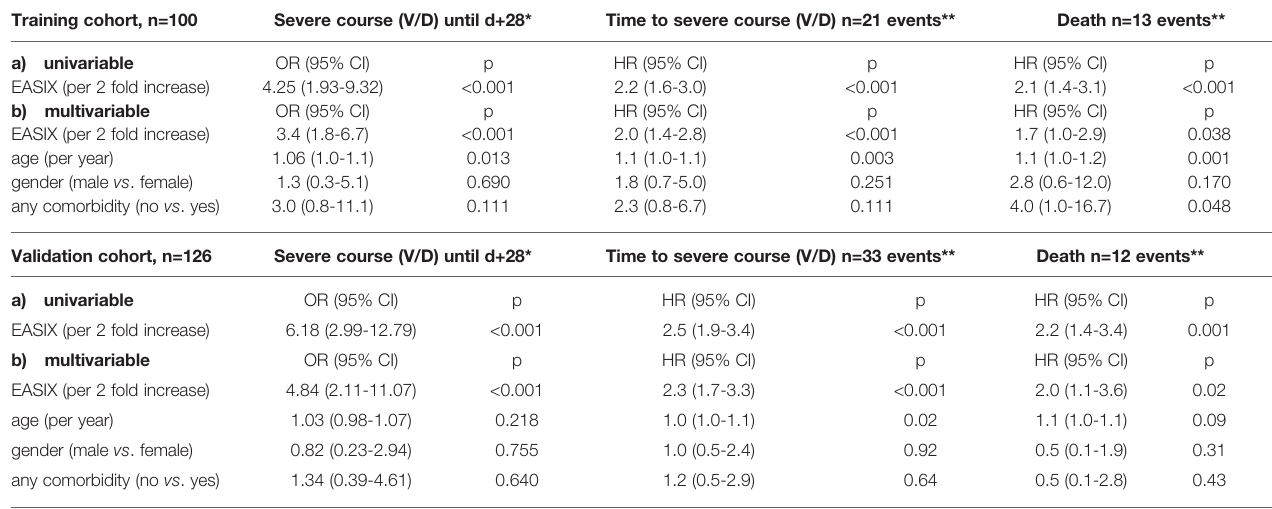
TABLE 2 | Uni- and multivariable analyses for endpoint severe course of the disease and survival in the training and validation